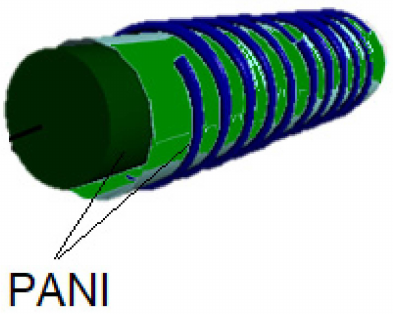
Figure 8. Three-dimensional image of the sprout with PANI wire. Laser irradiation of sprout/PANI showed light conduction along the sprout/PANI composite vessel fiber. Figure 9a,b show optical microscopy images of sprout/PANI with- out laser irradiation and with laser irradiation, respectively. The plausible light conduction depicted in Figure 10 indicates that the composite is a natural textile and the conducting polymer composite strings have a fine optical fiber function.